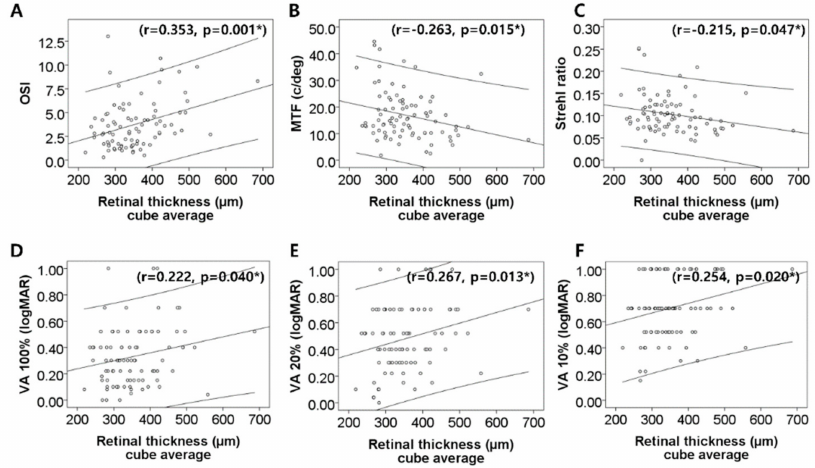
Figure 3. Correlation between the retinal thickness of cube average and optical quality value. A, D, E , F . Positive correlation with retinal thickness is showed in OSI and predicted visual acuities (PVA) at contrast levels of 100%, 20%, and 10%. B, C . While MTF and Strehl ratio showed negative correlation with retinal thickness. * Significant by Pearson correlation